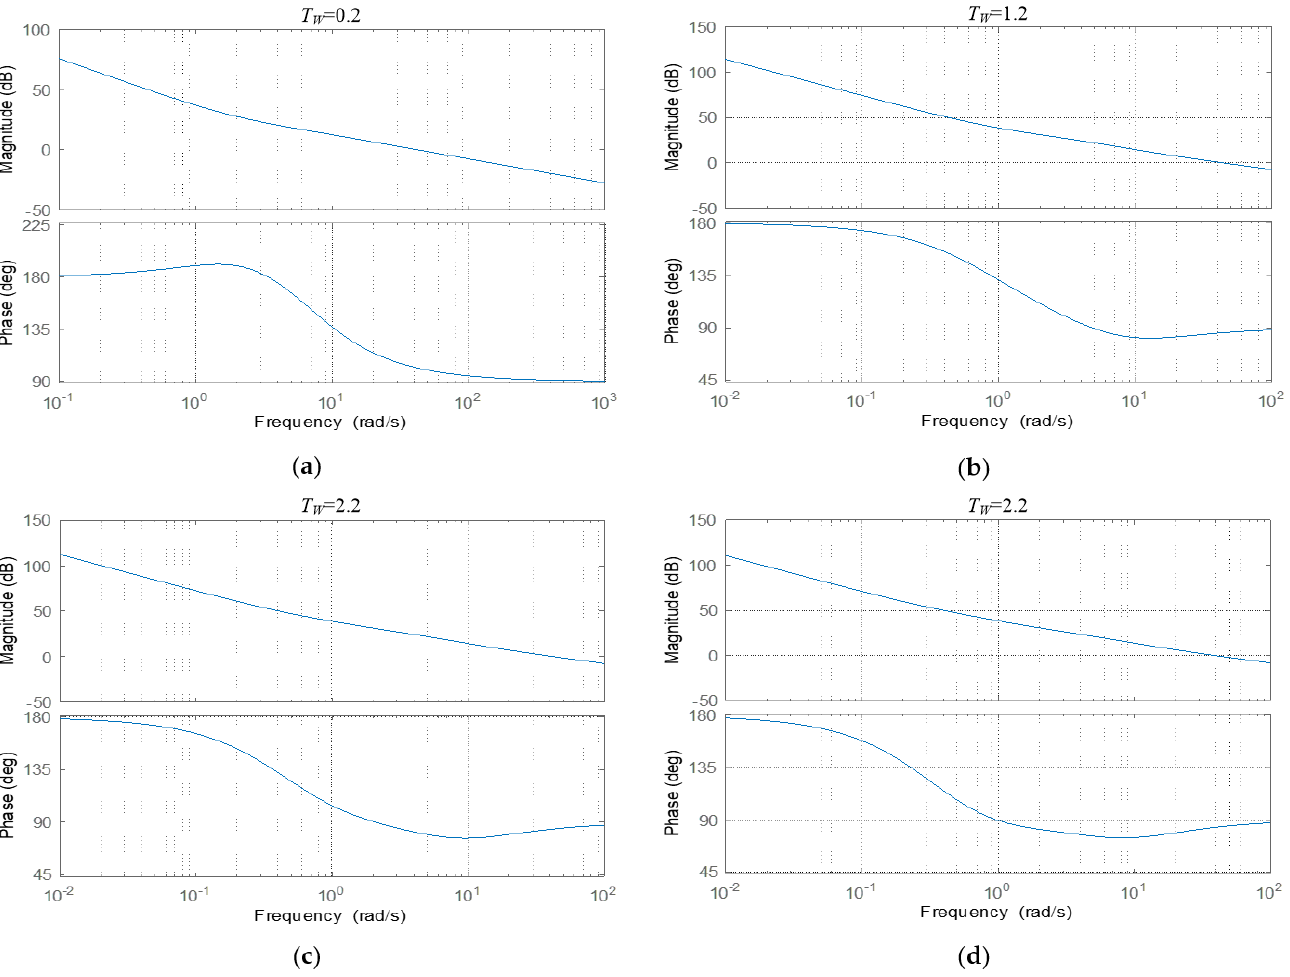
Figure 5. Block diagram of ORM.